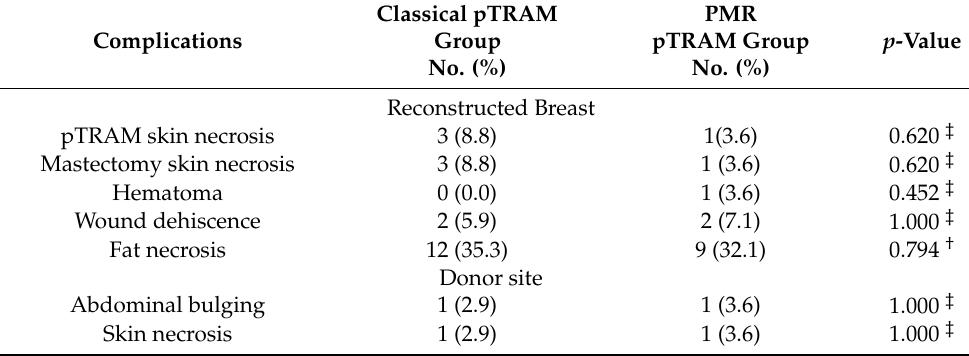
Table 2. Reconstructed breast and donor site complications.